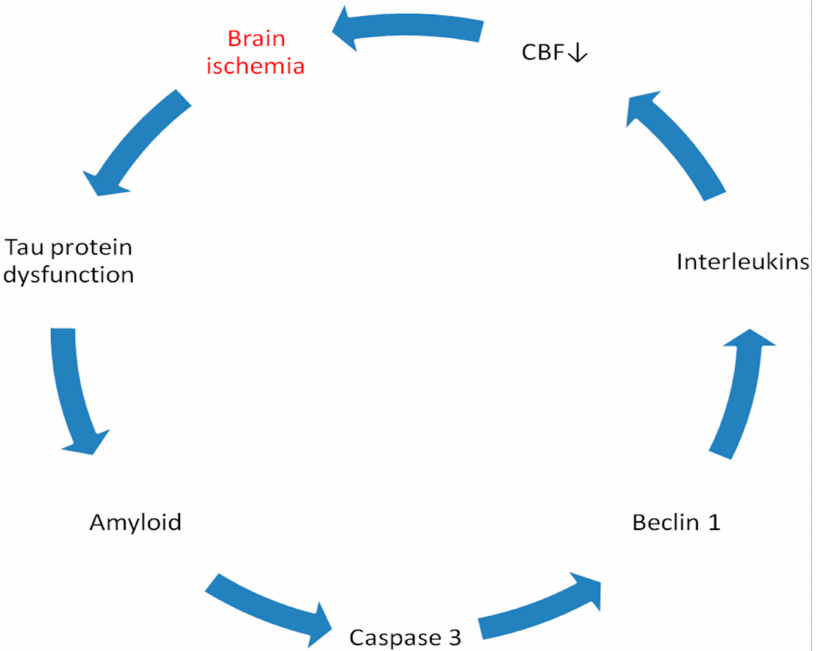
Figure 3. Cross talk between Alzheimer’s disease-associated proteins during post-ischemic brain injury. Beclin 1-protein associated with autophagy. CBF ↓ -decrease of cerebral blood